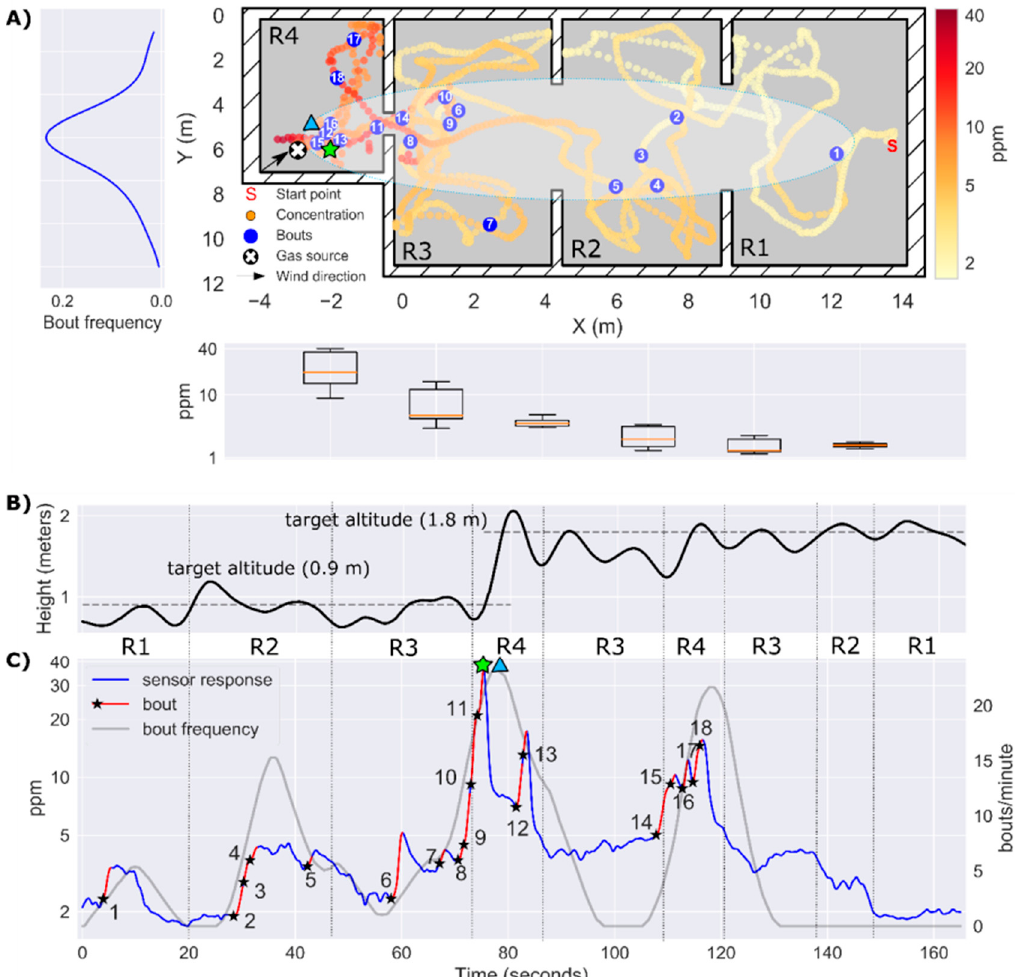
Figure 15. Results of Experiment 1. ( A ) 2D map of the instantaneous concentration (ppm) in log scale, with bouts represented by blue circles ( b thr = 0.52 ppm/s). A hand-drawn ellipse outlines the approximate plume shape based on the location of bouts. The average bout frequency along the y-axis is shown in the leftmost panel. The box plot below the map represents the instantaneous concentration along the x-axis; ( B ) Trajectory of the drone along the z-axis. ( C ) Temporal evolution of the instantaneous concentration (ppm) on a log scale, with detected bouts highlighted in red (the black star indicates the start of a bout). The identifiers R1–R4 between panels ( B ) and ( C ) indicate the area of the map in which the drone is flying at each moment. The maximum instantaneous concentration and the maximum bout frequency are indicated by a green star and a blue triangle, respectively.